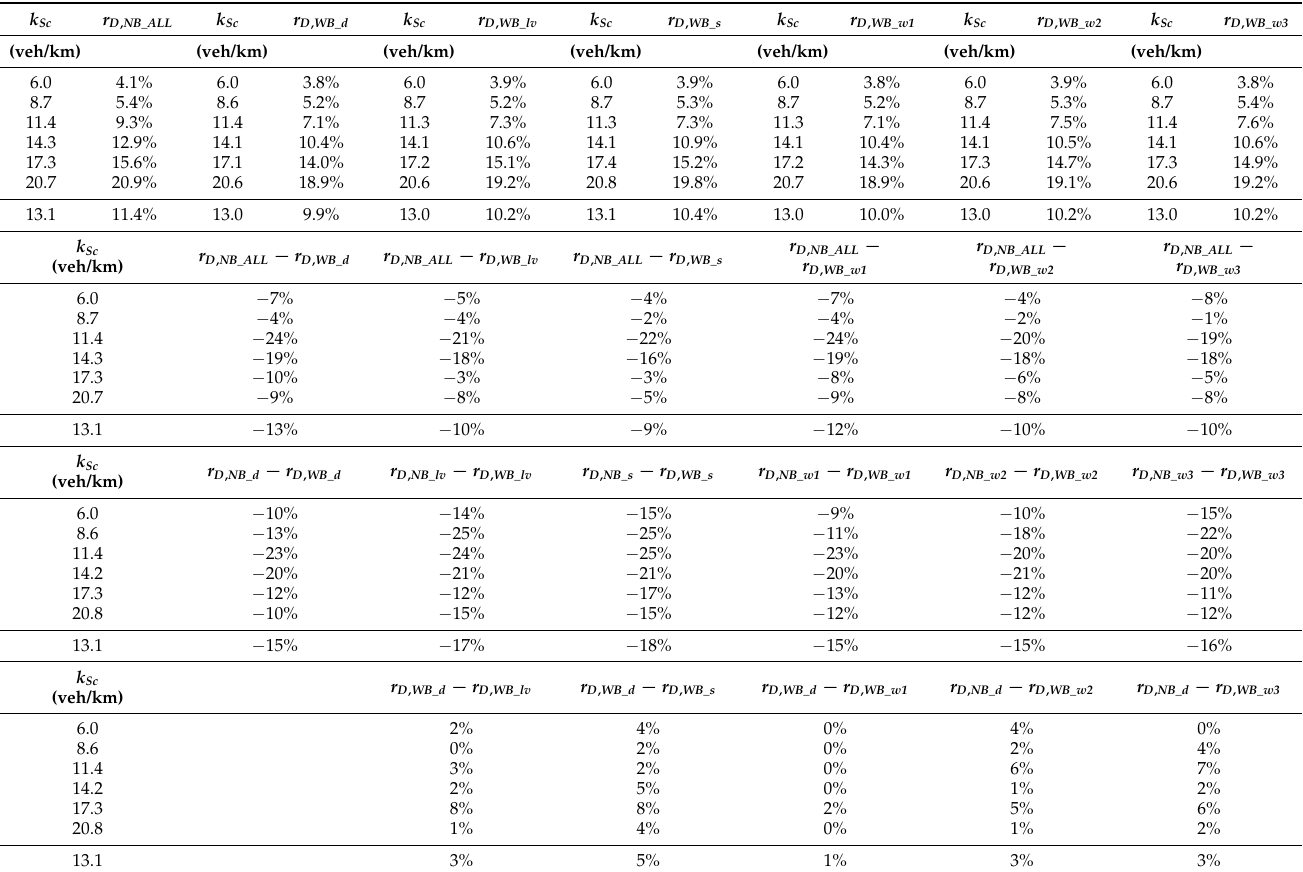
Table 2. Relative delays of vehicles depending on traffic density for simulation scenarios NB_ALL and WB_c , along with relative differences for the “average”